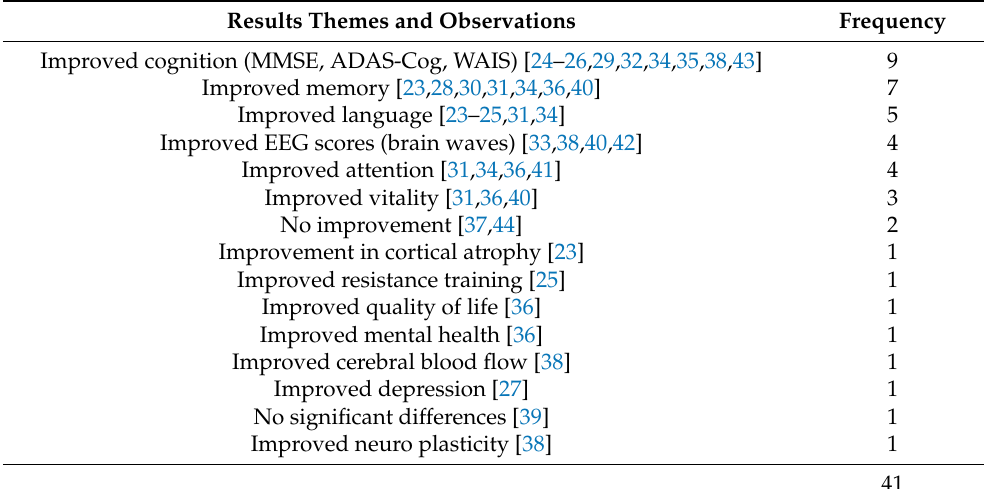
Table 3. Results to the adoption of mHealth and VR for memory care. Results Themes and